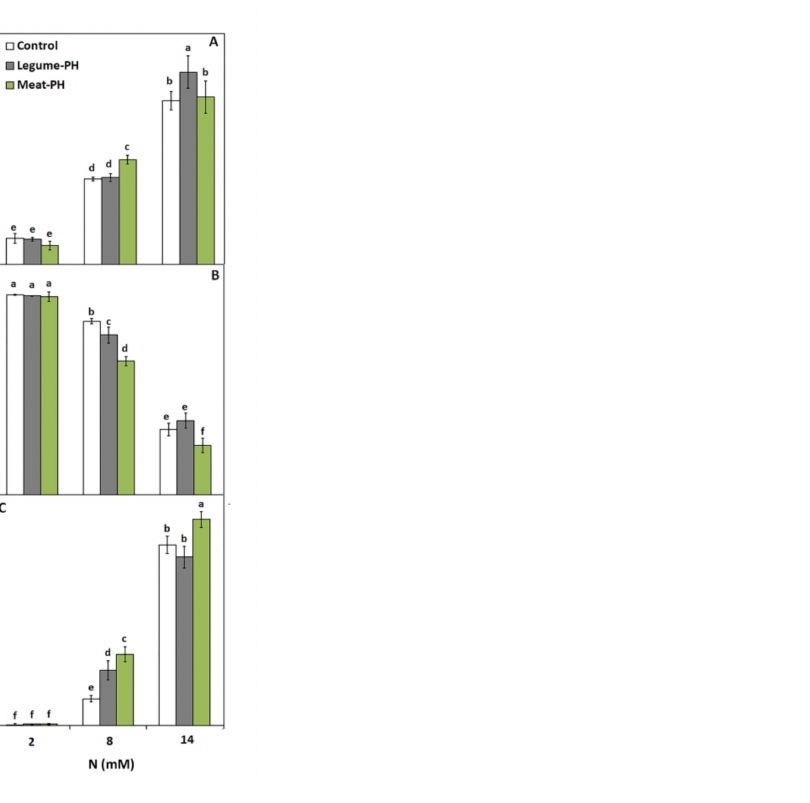
Figure 4. Effect of nitrogen doses and foliar application of biostimulants on N uptake ( A ), reduced-N ( B ), and nitrate concentration ( C ) of spinach leaves. Vertical bars (standard error) ( n = 9) with different letters are significantly different according to the LSD test ( p =